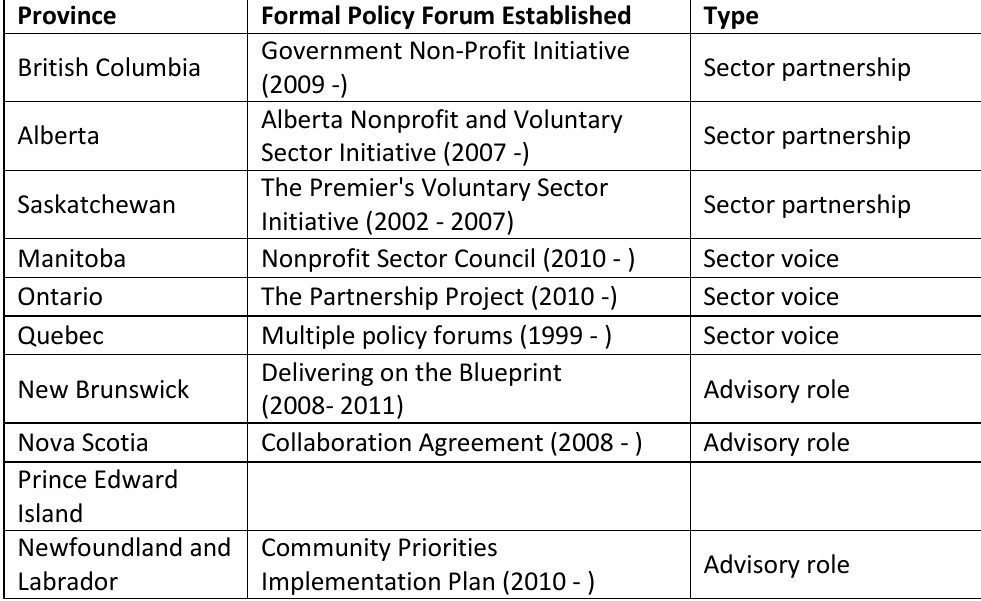
Table 4: Provincial Voluntary Sector-Government Policy